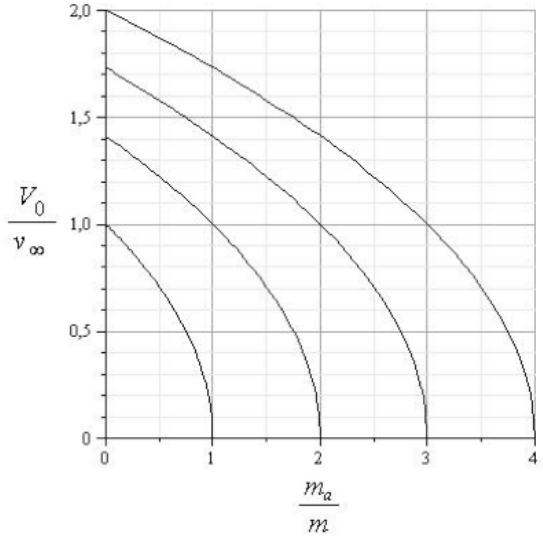
Figure 2. Critical ratio V 0 / ν ∞ as a function of the quotient m a / m